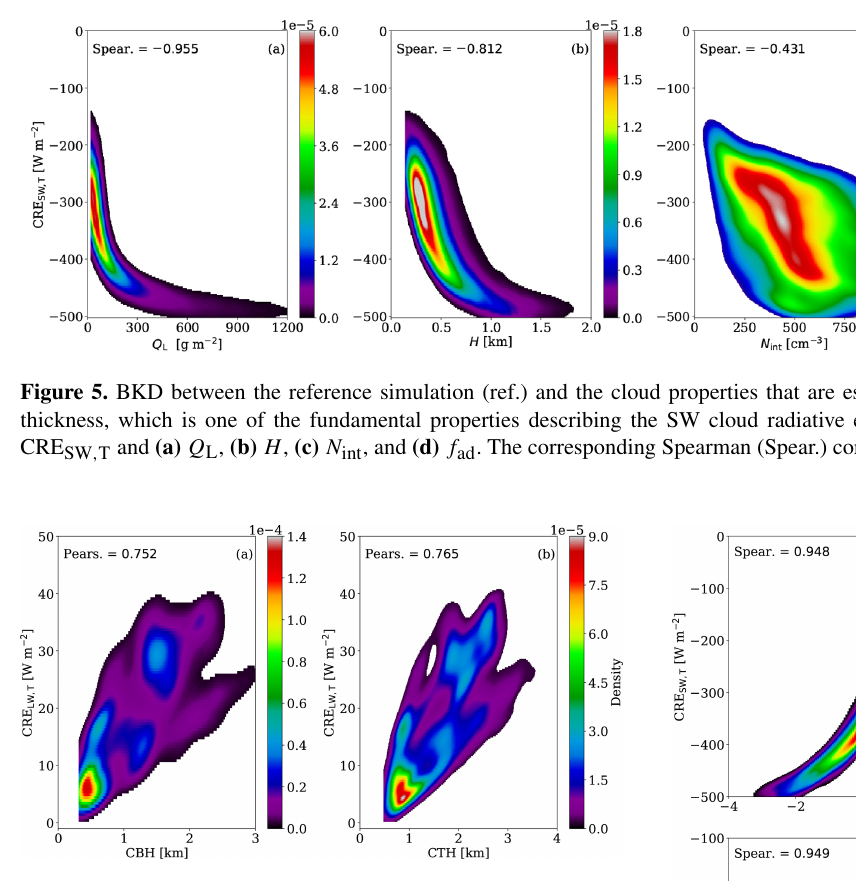
Figure 6. BKD between the reference simulation (ref.) and the cloud properties describing the LW cloud radiative effect at the TOA, and (a) CBH and (b) CTH. The corresponding Pearson (Pears.) correlations are highlighted.